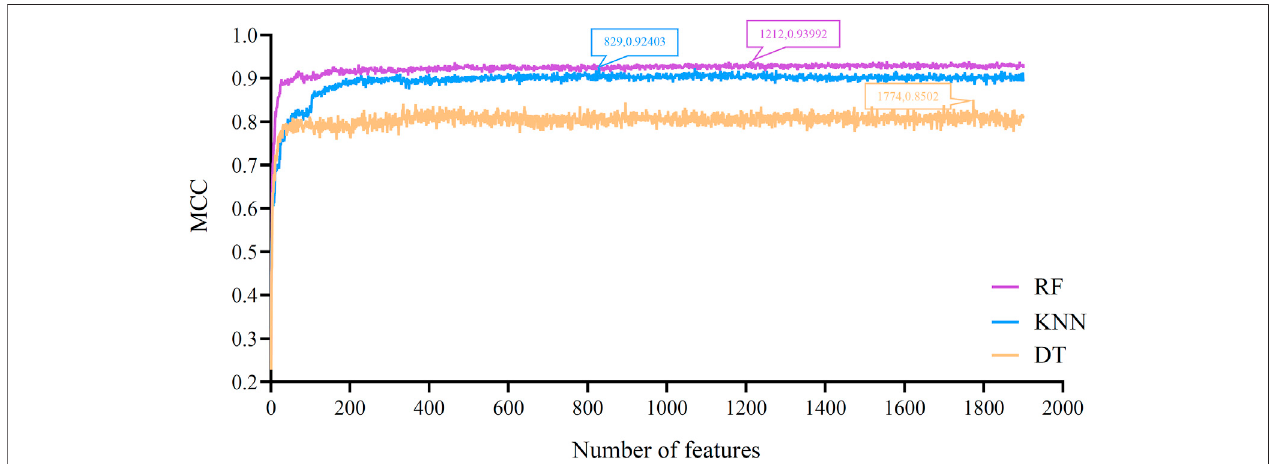
FIGURE2| IFScurvesforevaluatingtheperformanceofthethreeclassi fi cationalgorithmsunderdifferentfeaturesubsetsaccordingtoMCC.RF/KNN/DT reaches the maximum MCC value of 0.940/0.924/0.850 at the feature number of 1212/829/1774.